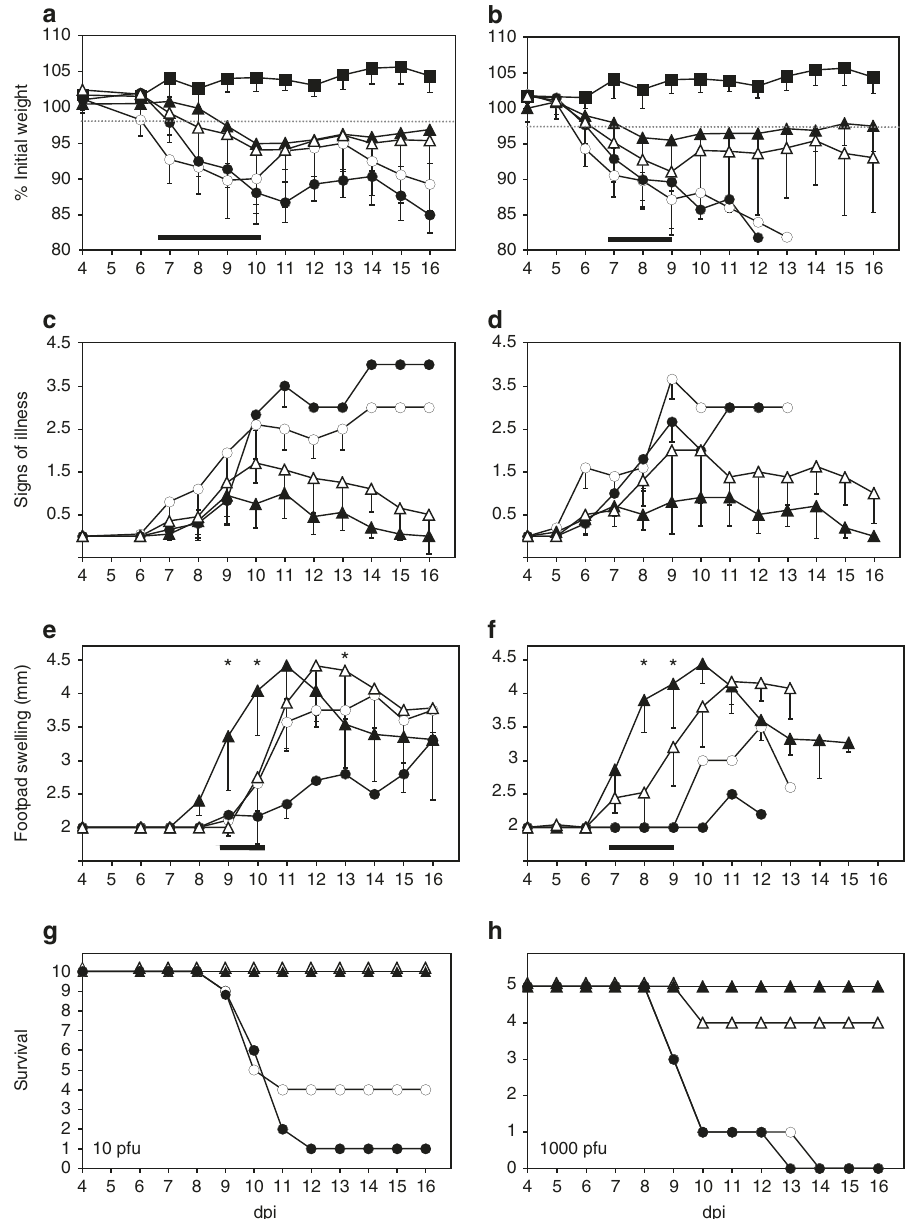
Fig. 2 Mousepox pathogenesis in the absence of ECTV CrmD. Groups of 10 ( a, c, e, g ) or 5 ( b, d, f, h ) BALB/c mice were inoculated s.c. in the left hind footpad with 10 PFU or 1000PFU, respectively, of ECTV (white circles), ECTV Δ CrmD (black triangles), ECTVRevCrmD (black circles), ECTVRevCRD (white triangles) or PBS alone (black squares), and monitored daily for weight loss ( a, b ), signs of illness ( c , d ) and footpad swelling ( e , f ), as indicated. Data are shown as mean + / − SEM. Statistical analyses were performed using multiple t -tests with false discovery rate at Q = 1%. Analyses were performed up to times post infection at which survival rates in the corresponding group were above 50%. Black bars indicate time points at which signi fi cant differences ( p < 0.01) between ECTV − / ECTVRevCrmD − and ECTV Δ CrmD-inoculated mice were found. Asterisks indicate time points at which signi fi cant differences ( p < 0.01) between ECTV Δ CrmD and ECTVRevCRD-inoculated mice were found. g , h The number of surviving animals